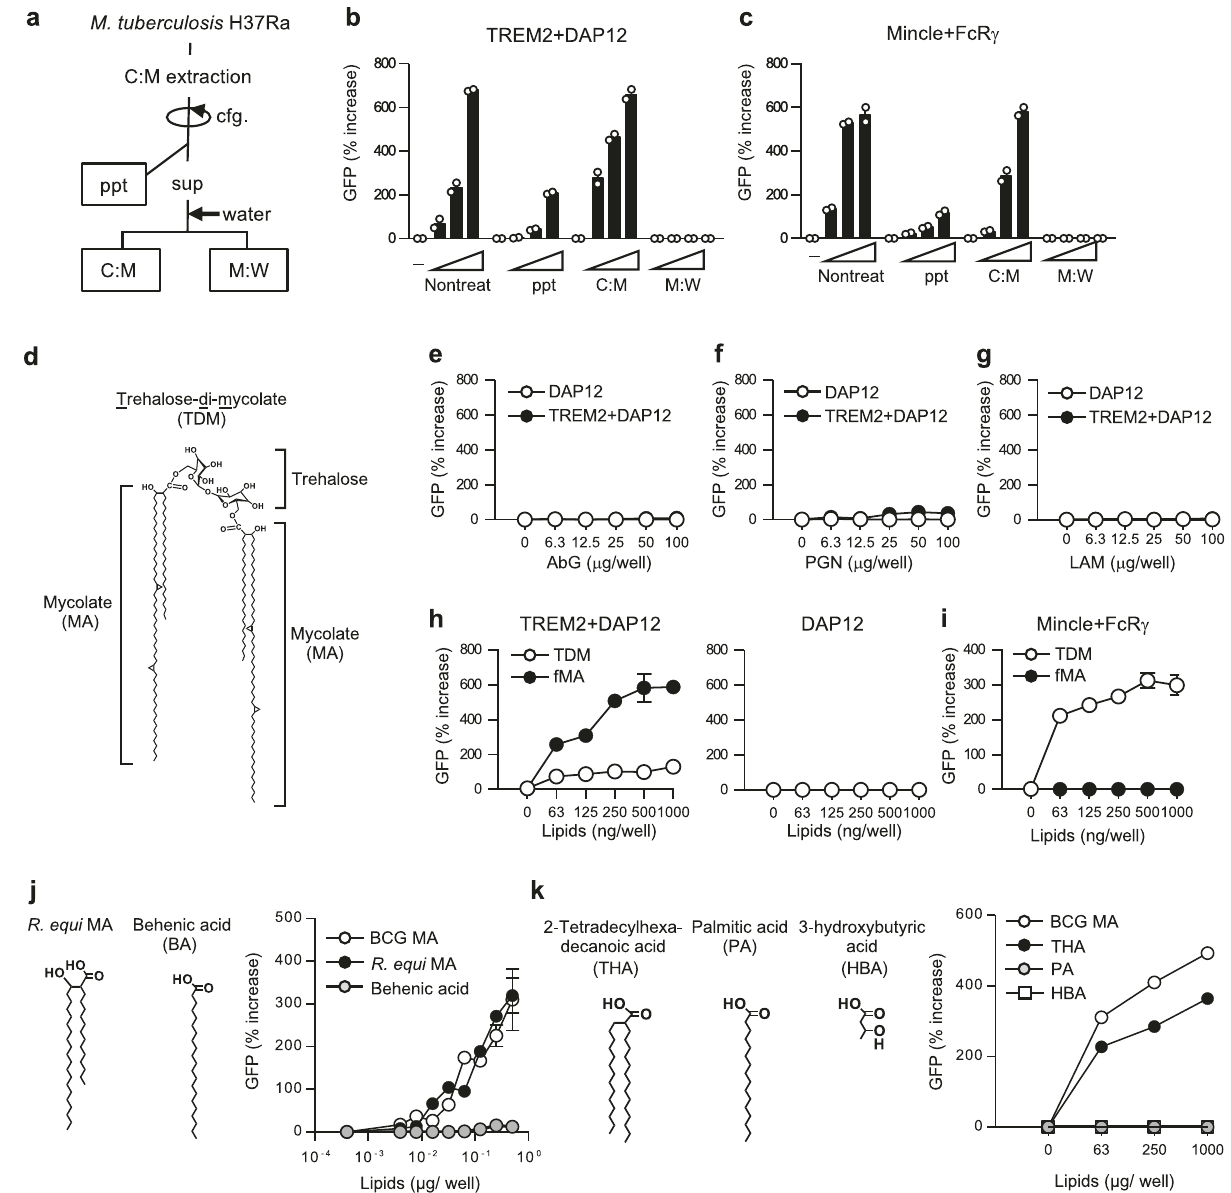
Fig. 2 TREM2 recognizes MAs. a Schematic diagram of solvent-based de-lipidation and fractionation of Mtb H37Ra. Bacteria were de-lipidated by the treatment with chloroform/methanol. After centrifugation (cfg.), soluble extracts (sup) were mixed with water and separated into the lipid-soluble (C:M) and the water-soluble methanol:water (M:W) fractions. b , c NFAT-GFP reporter cells expressing TREM2 + DAP12 ( b ) or Mincle + FcR γ ( c ) were stimulated for 24 h with either untreated or de-lipidated bacteria (ppt) or plate-coated C:M or M:W fractions indicated in a , followed by analysis of GFP fl uorescence by fl ow cytometry. d Chemical structure of TDM. The structure of α -mycolate-containing TDM is shown. e – g NFAT-GFP reporter cells expressing TREM2 + DAP12 or DAP12 alone were stimulated with the indicated amounts of ABG ( e ), PGN ( f ), and LAM ( g ) for 24 h, followed by analysis of GFP fl uorescence by fl ow cytometry. Data are presented as percent increase over control values of unstimulated cells. h , i NFAT-GFP reporter cells expressing TREM2 + DAP12 or DAP12 only ( h ) or Mincle + FcR γ ( i ) were stimulated with the indicated amounts of TDM or fMA, and analyzed as described in e – g . j , k NFAT-GFP reporter cells expressing TREM2 + DAP12 were stimulated with the indicated amounts of BCG MA, R. equi MA, or BA ( j ) or THA, PA, or HBA ( k ) and analyzed as described in e – g . Data are presented as the mean ± SEM of duplicate ( b , c , e – i , j ) or triplicate ( k ) assays and representative of three independent experiments. Source data are provided as a Source data fi